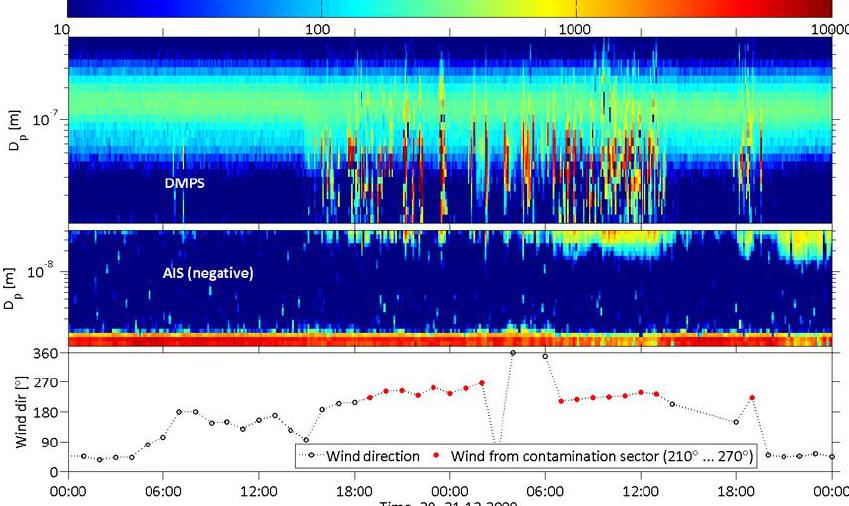
Fig. 12. Contamination at Aboa, 20–21 December 2009. Upper and middle panel show the neutral (10–500nm, upper) and negatively charged (0.8–42nm, middle) particle size distribution, while the lowermost panel shows the 1h averaged wind direction. Wind direction values marked with red are coming from the contamination sector. The contamination sector at Aboa is well defined, and during the campaign wind blew from this sector only 4.6% of the time. The colour scale in size distributions is dN/dlog D p , unit cm − 3 .